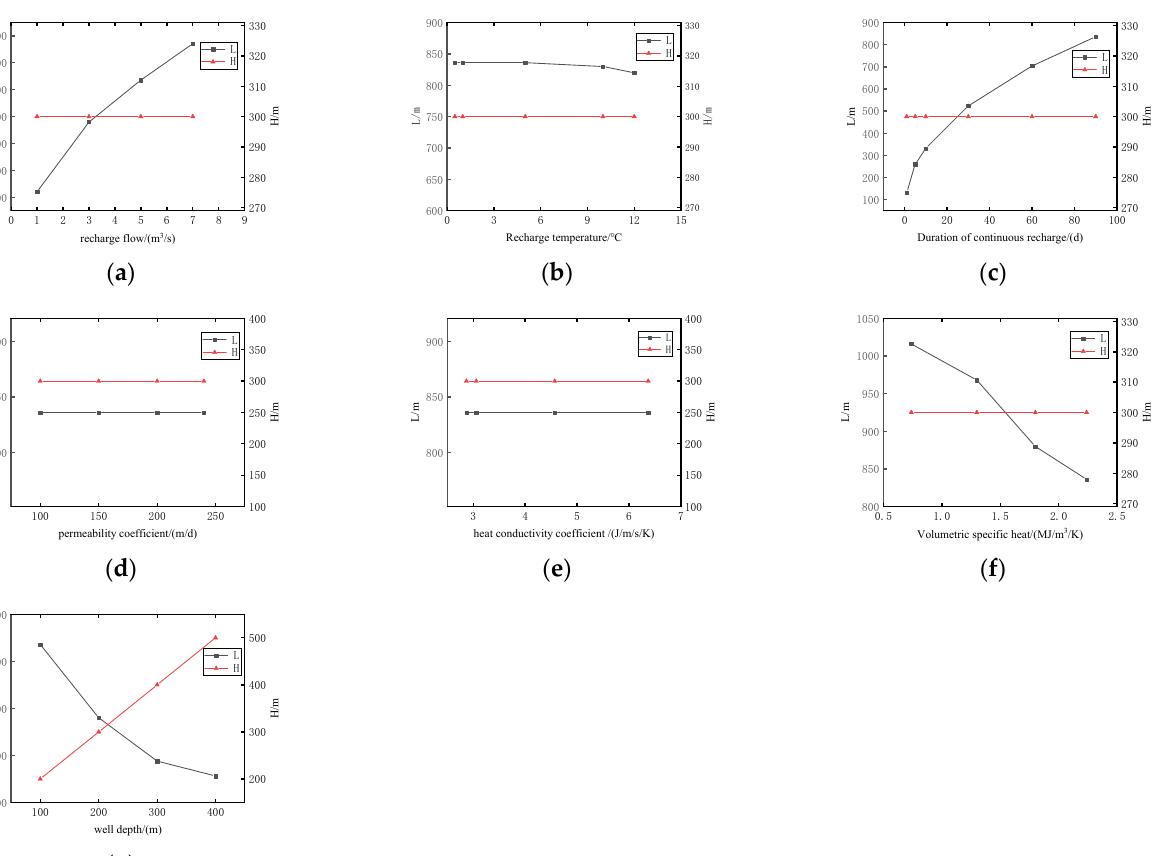
Figure 12. Temperature changes under the influence of different factors: ( a ) recharge flow, ( b ) recharge water temperature, ( c ) duration of continuous recharge, ( d ) permeability coefficient, ( e ) thermal conductivity of soil, ( f ) specific volume heat of soil, and ( g ) well depth.